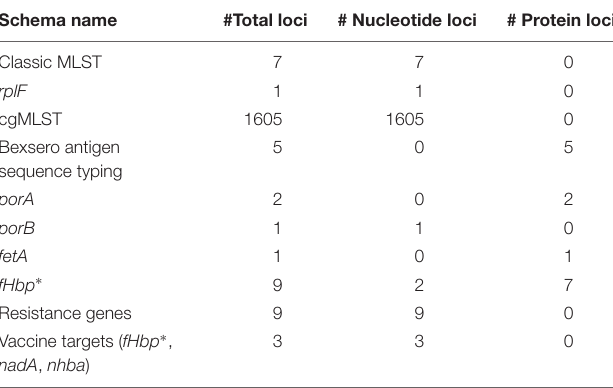
TABLE 2 | Overview of employed typing schemas # .